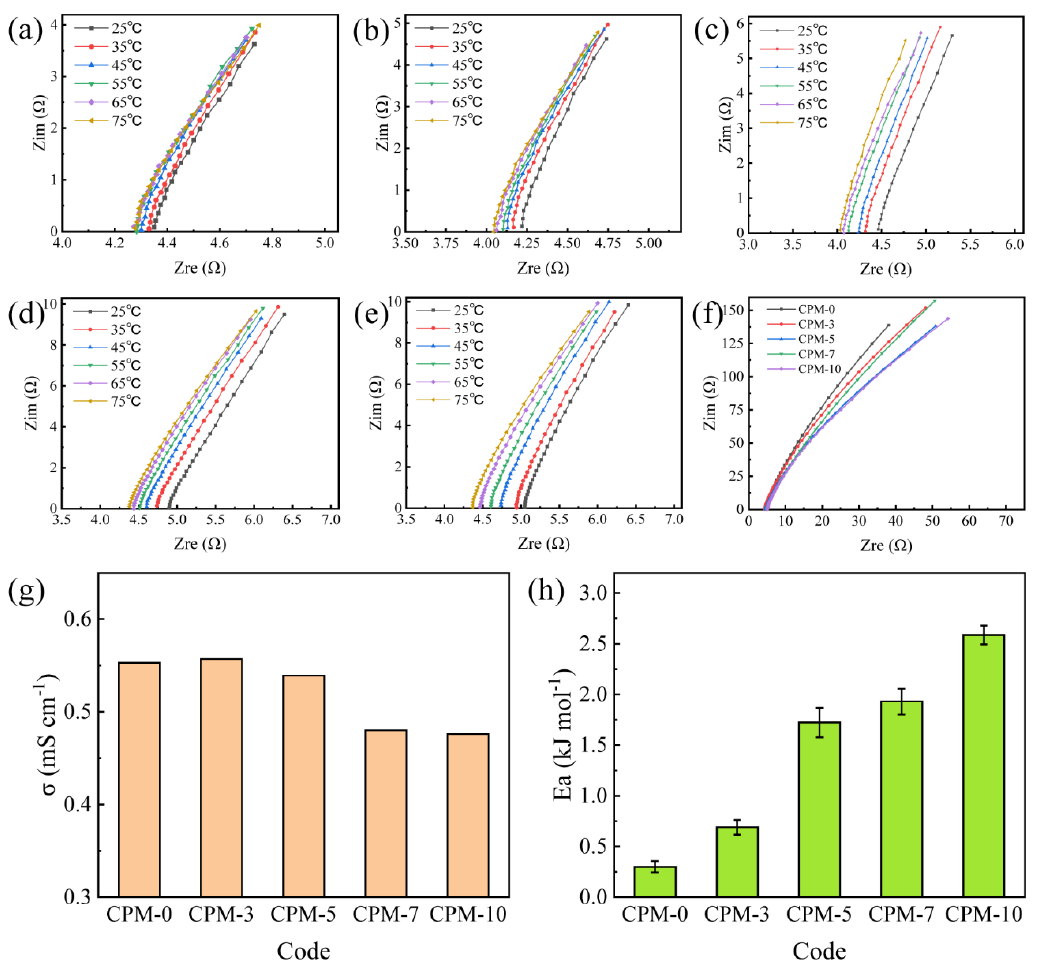
Figure 6. EIS plots at different temperatures for the CPM gel electrolyte: ( a ) CPM-0; ( b ) CPM-3; ( c ) CPM-5; ( d ) CPM-7; ( e ) CPM-10; ( f ) EIS plots of the samples at 25 °C at a frequency of 100 Hz – 100 kHz; ( g ) ionic conductivity of CPM gel; ( h ) activation energy of CPM gel.